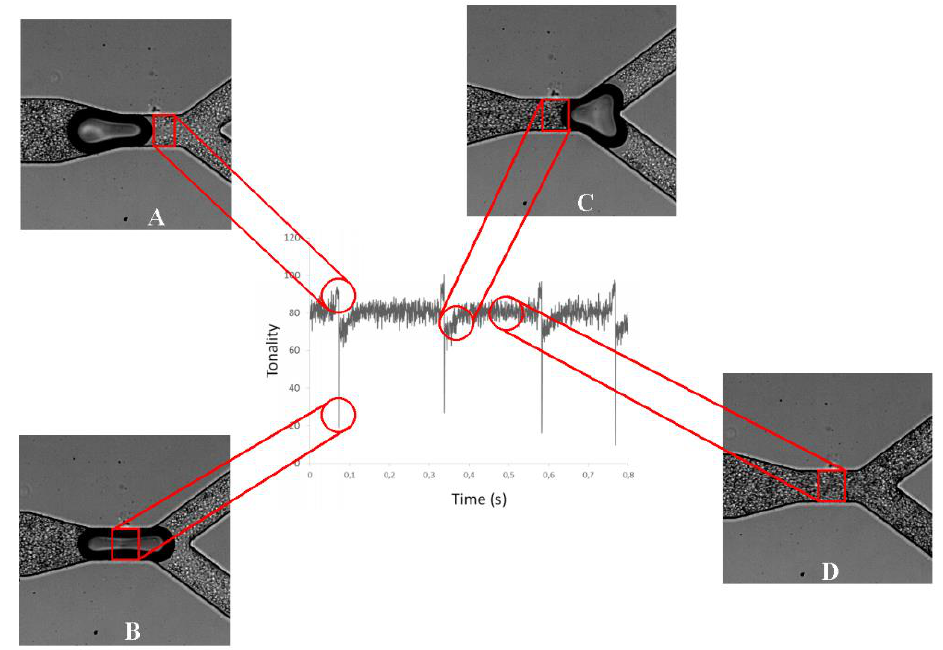
Figure 7. Application of the plot Z-axis profile function at the selected region of interest (ROI), for a Hct of 10% and at the first bifurcation (B1).